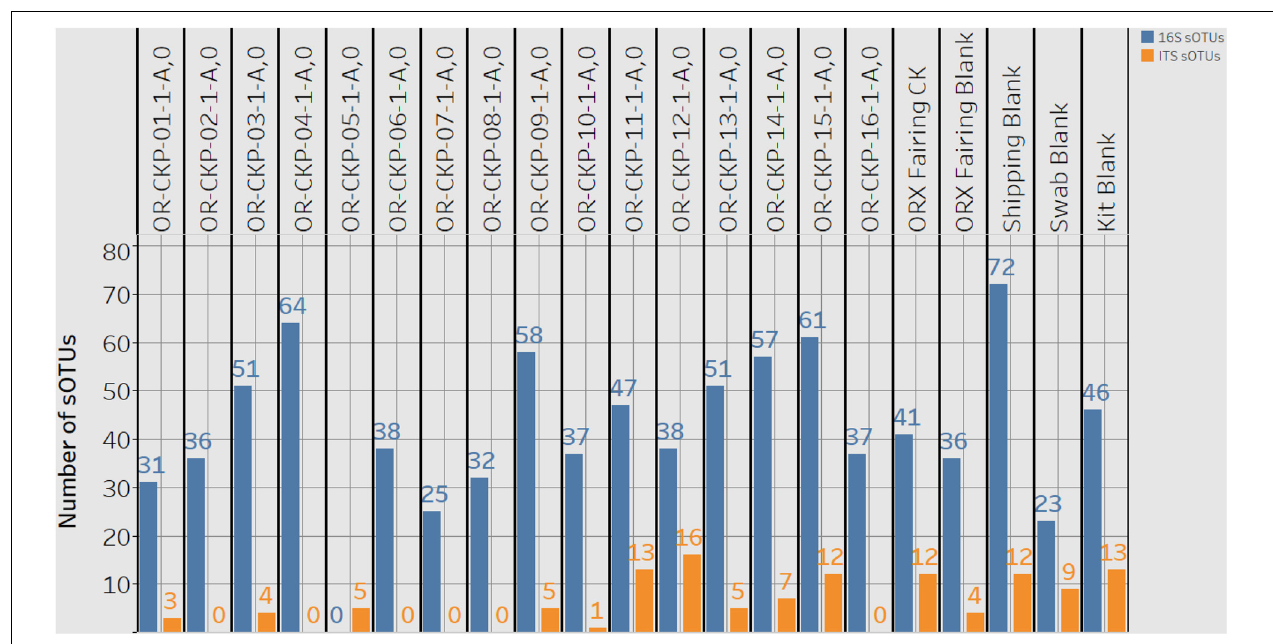
FIGURE 4 | A plot detailing the number of 16S rRNA gene or bacterial sOTUs (blue bars) and ITS or fungal sOTUs identified in each sample. 16S rRNA gene samples with < 5,611 16S rRNA gene sequences are listed as having zero sOTUs. ITS samples with zero sequences also have zero sOTUs.